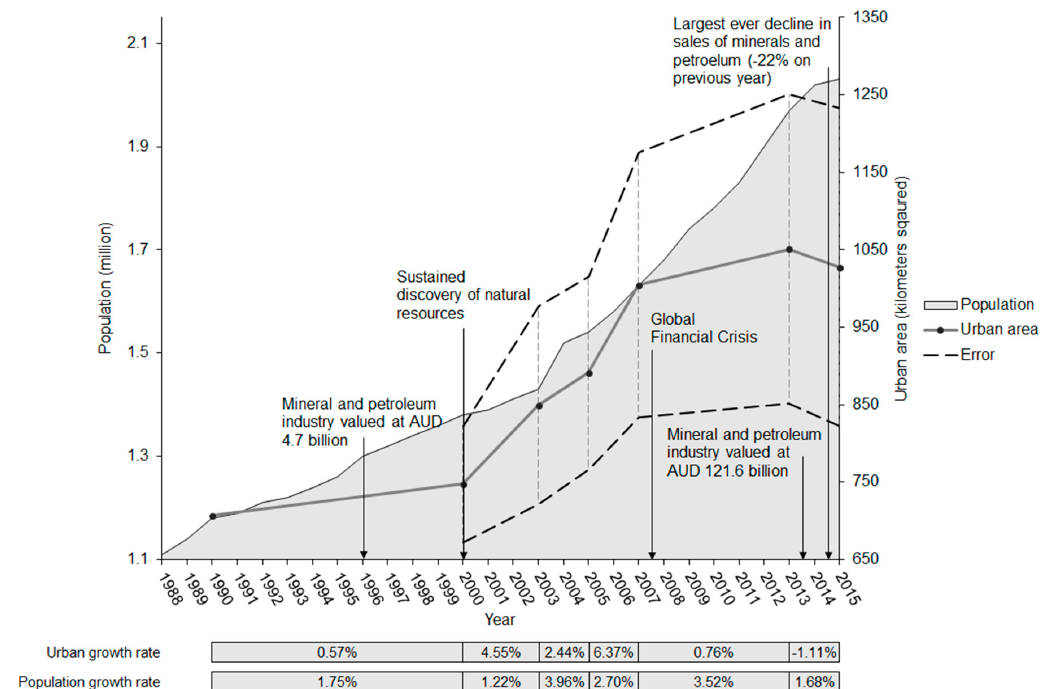
Figure 3. Time line of urban expansion in kilometers squared derived from Earth observation data with associated classification error derived from validation data (points indicating classified image years). Alongside population data in millions per year since 1988 (based on Australian Bureau of Statistics data, 2015 data is projected) with key natural resource milestones indicated, and average annual urban and average annual population growth rate indicated between classified image years.